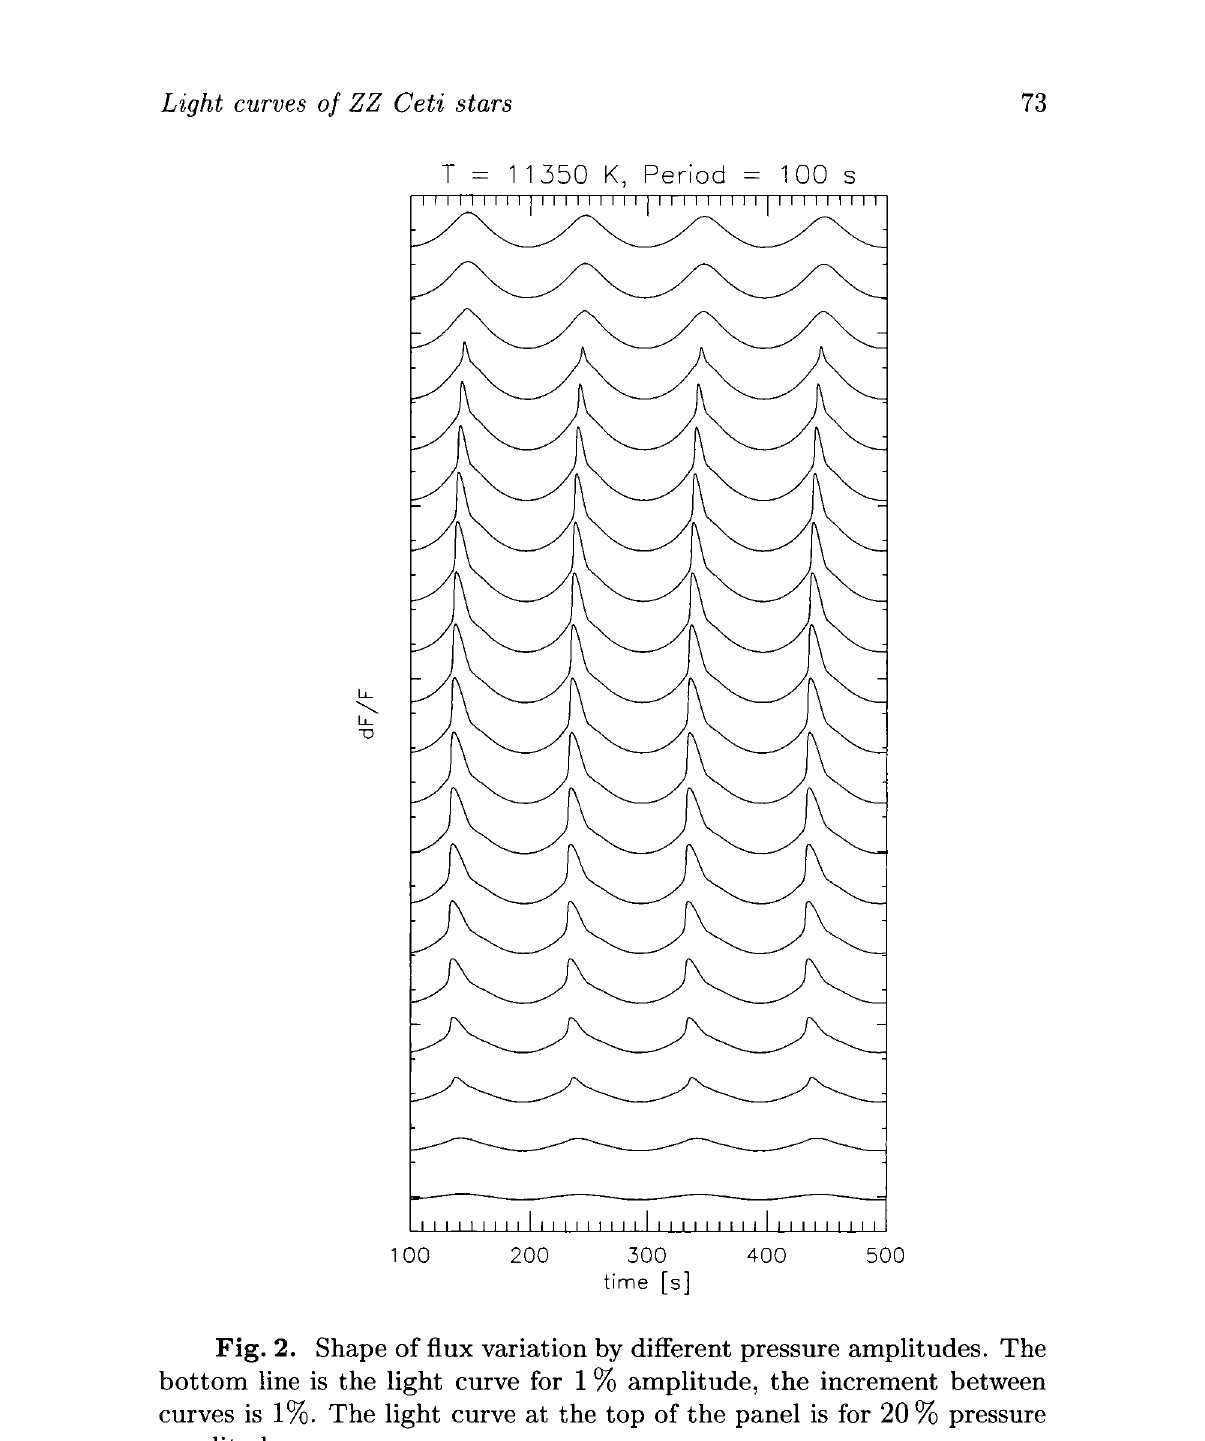
Fig. 2. Shape of flux variation by different pressure amplitudes. The bottom line is the light curve for 1 % amplitude, the increment between curves is 1%. The light curve at the top of the panel is for 20% pressure